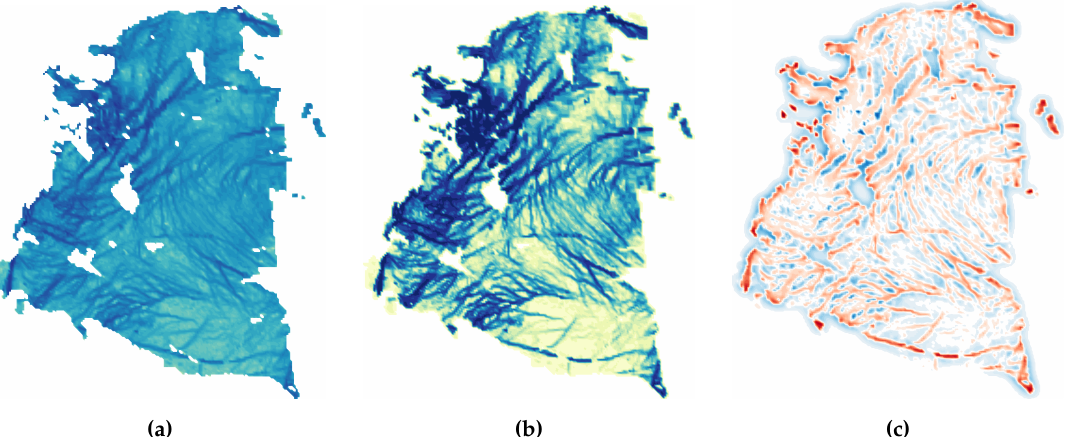
Figure 2. Image enhancement: ( a ) Logarithm-scaled total deformation I l ; ( b ) Result of histogram equalization; ( c ) DoG (Difference of Gaussian) filtered image. red: I f > 0, blue: I f <